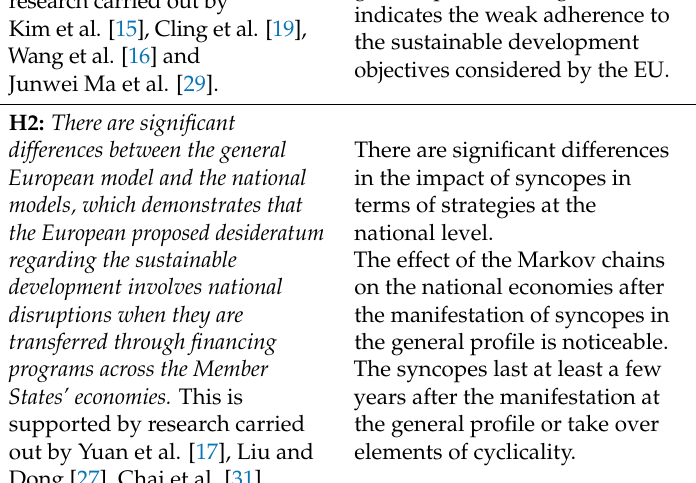
Table 11. Connecting research hypotheses with policy suggestions.